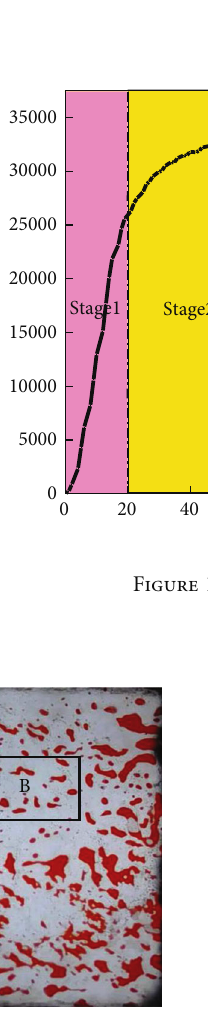
Figure 11: Residual distribution of PCE in fracture